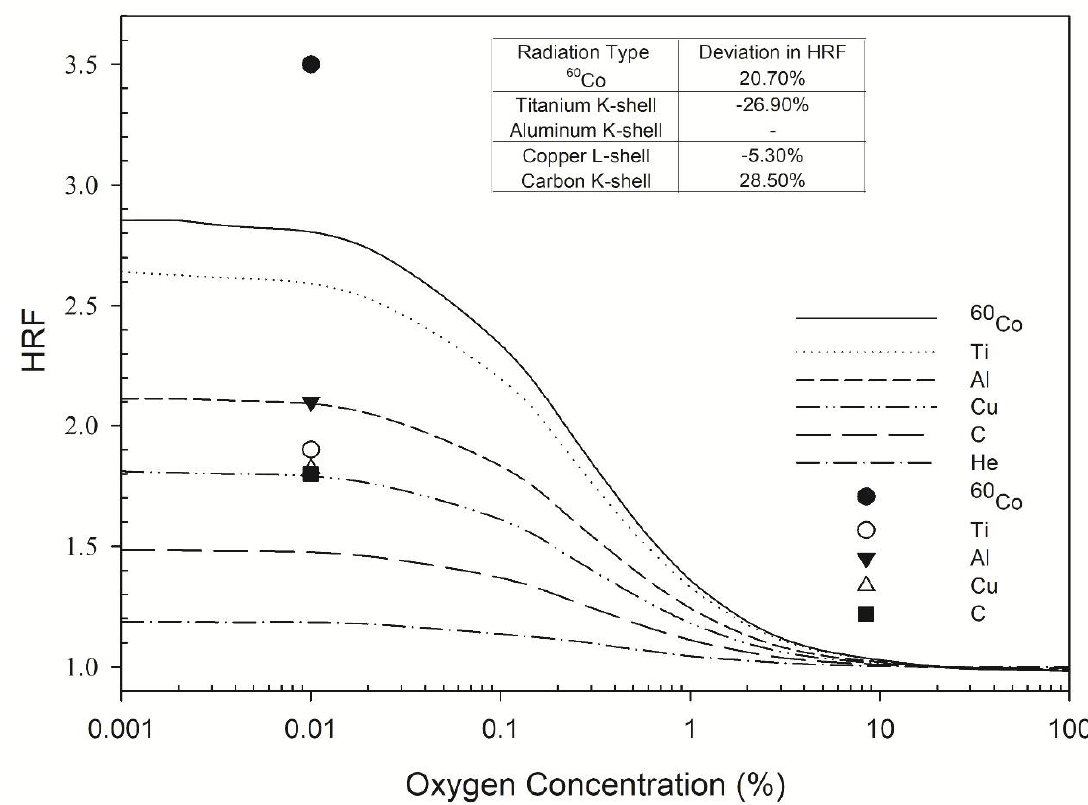
Figure 1. HRF for DSB induction as a function of oxygen concentration. The symbols Ti, Al, Cu, and C represent titanium K-shell, aluminum K-shell, copper L-shell, and carbon K-shell radiation, respectively. The lines indicate the Monte Carlo damage simulation results (this work) and the individual symbols represent the experimental results of de Lara et al. (2001)